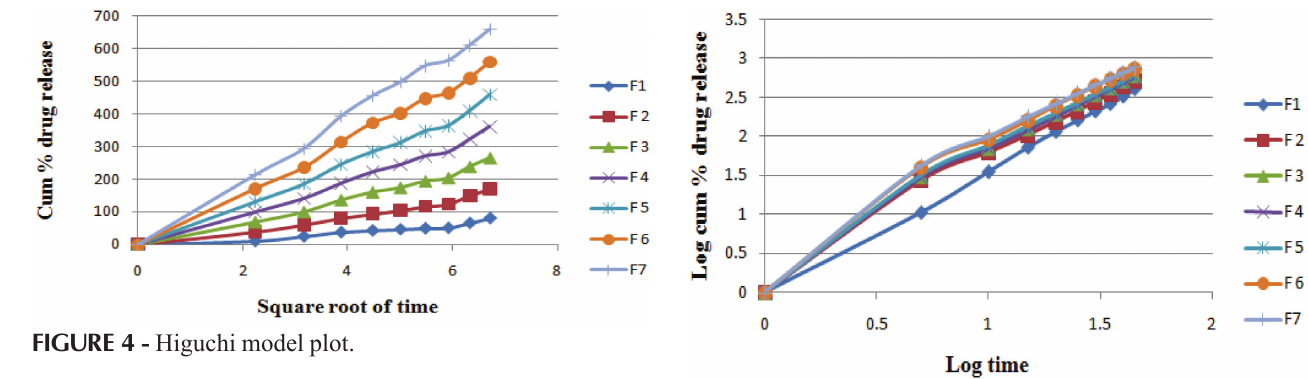
FIGURE 6 - Krosmeyers-Peppas model plot.